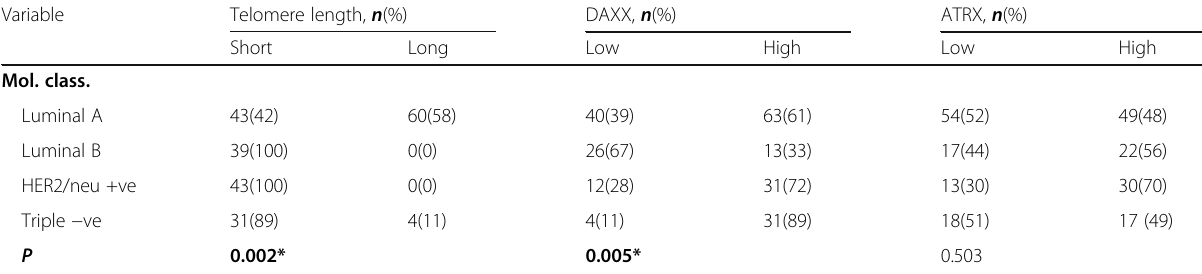
Table 4 Association of telomere length, DAXX, ATRX expression, and clinicopathological parameters (Continued)